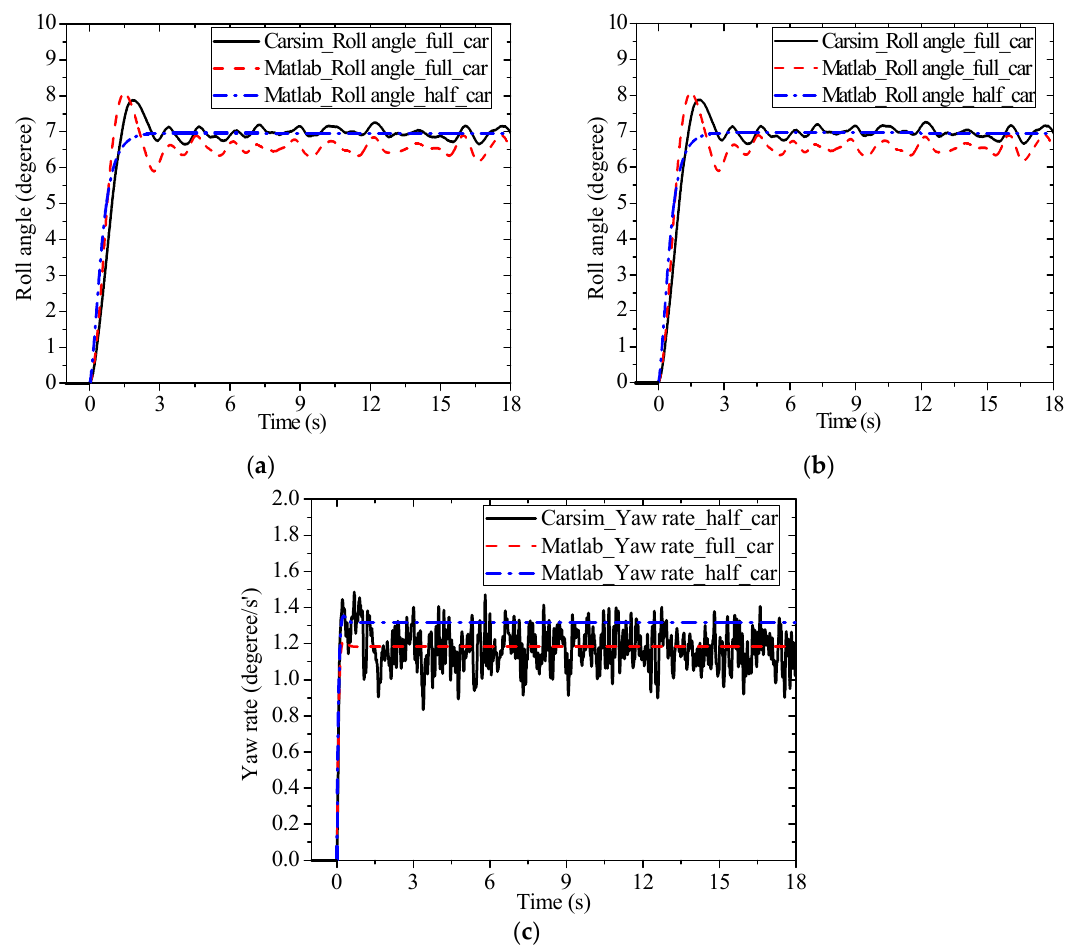
Figure 10. Results with road Level ISO- A excitation (steering wheel angle was 10° at 80 km/h). ( a ) Roll angle, ( b ) Roll rate, ( c ) Yaw rate.